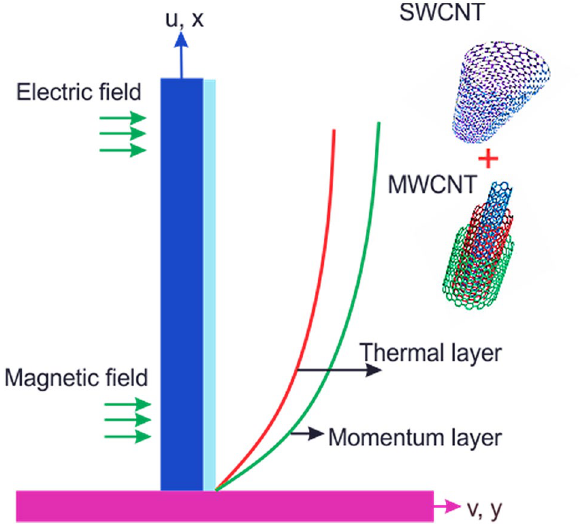
Figure 1. Geometry of the